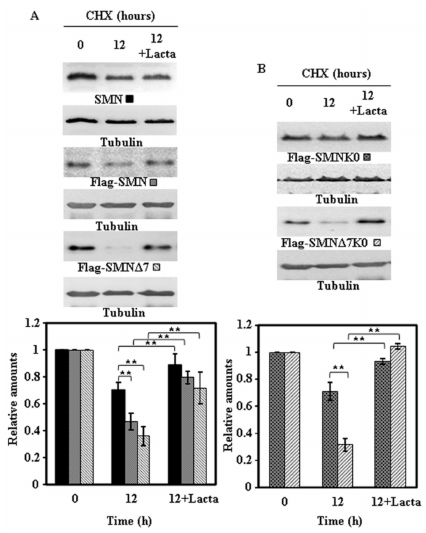
Figure 7. Effect of proteasome inhibition on the degradation of endogenous and ectopically expressed Ffag-SMN or Flag-SMN ∆ 7 constructs in HeLa cells. Untransfected (endogenous SMN) or transiently transfected HeLa cells with Flag-SMN or Flag-SMN ∆ 7 ( A ) and Flag-SMNK0 or Flag-SMN ∆ 7K0 ( B ) were treated with CHX in the absence or in the presence of Lactacystin (Lacta) for the indicated times and cell extracts were analyzed by immunoblot with SMN or anti-Flag specific antibodies. Anti-tubulin antibodies were used as total protein loading control. The graphs below show the quantification of the corresponding immunoblots. Values are expressed as mean ± S.E.M. from three different experiments. Asterisks indicate a statistical significant difference between pairs (** p < 0.01, Student’s t -test). n.s., not significant.